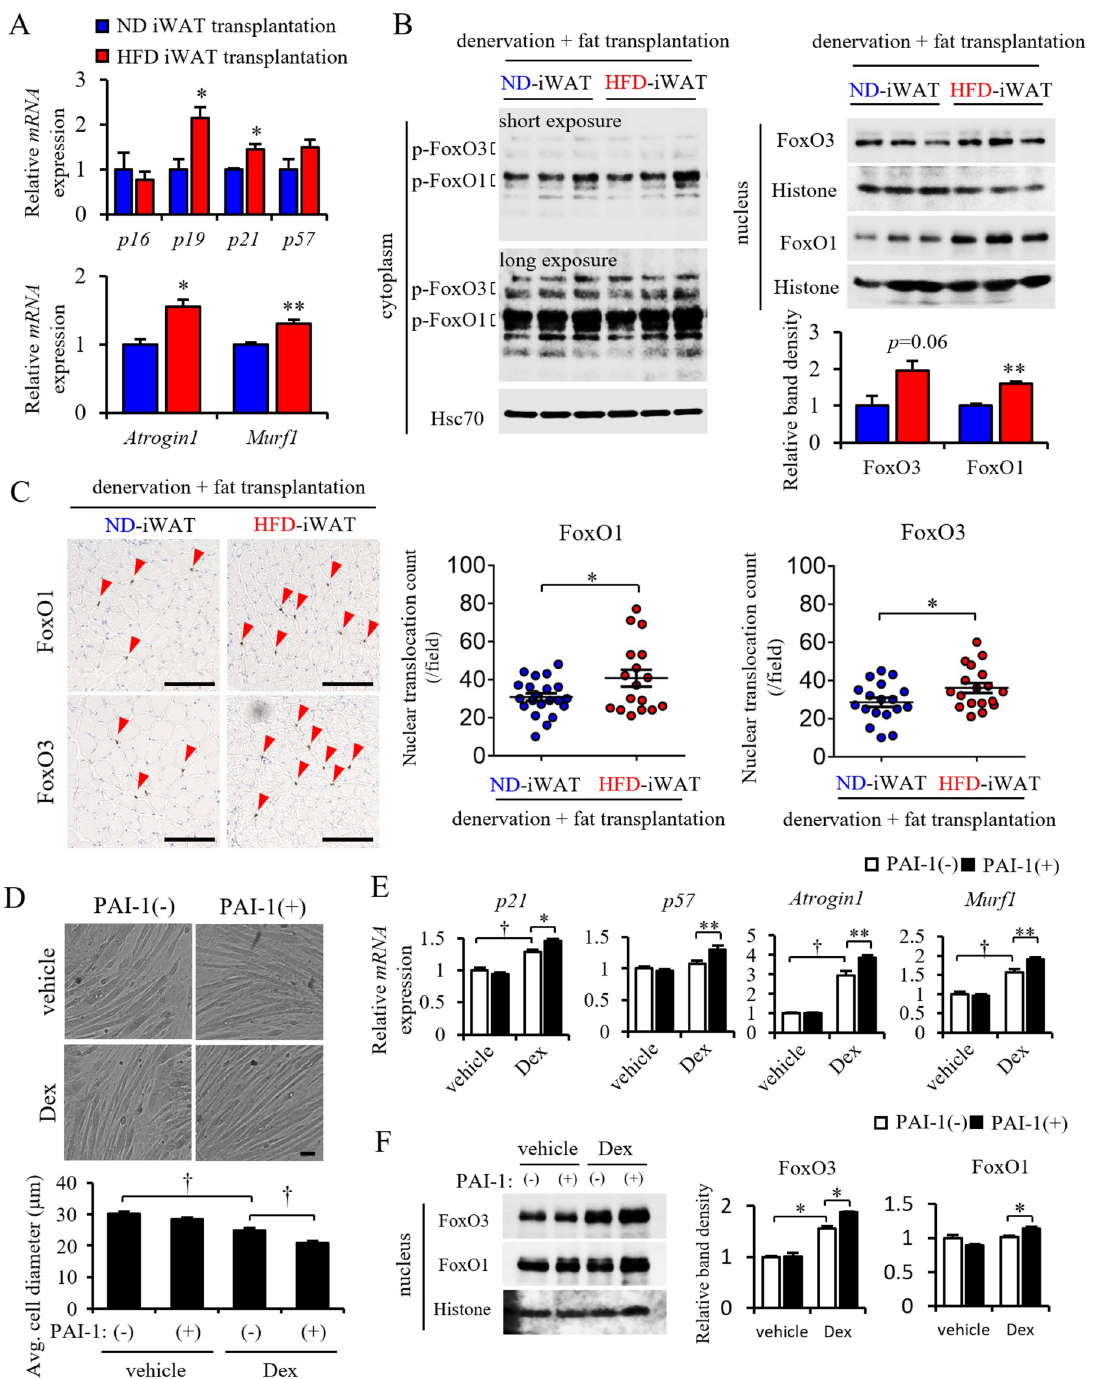
Fig 5. The presence of PMAT induces muscle senescence and up-regulates FoxO-Atrogin1/Murf1 signaling. (A) Relative transcript levels of senescence-related genes ( p16 , p19 , p21 and p57 ) and Atrogin1 Murf1 in skeletal muscle of mice transplanted with ND or HFD iWAT (n = 6 per group). (B) Representative western blot images of phosphorylated FoxO3 and FoxO1 protein in the cytoplasm (left panel) and corresponding total protein in the nucleus (right top panel) of skeletal muscle from mice transplanted with ND or HFD iWAT. Corresponding quantification of total FoxO3 and FoxO1 protein in the nucleus (right bottom panel) (n = 3 per group). Hsc70 or Histone staining served as internal loading controls. (C) Representative images (left panels) and quantification (right panels) of the number of nuclear FoxO1- or FoxO3-positive cells in skeletal muscle from mice transplanted with ND or HFD iWAT. (D) Representative images (top panels) and quantified diameters (bottom panel) of differentiated C2C12 myotubes after PAI-1 and dexamethasone (Dex)